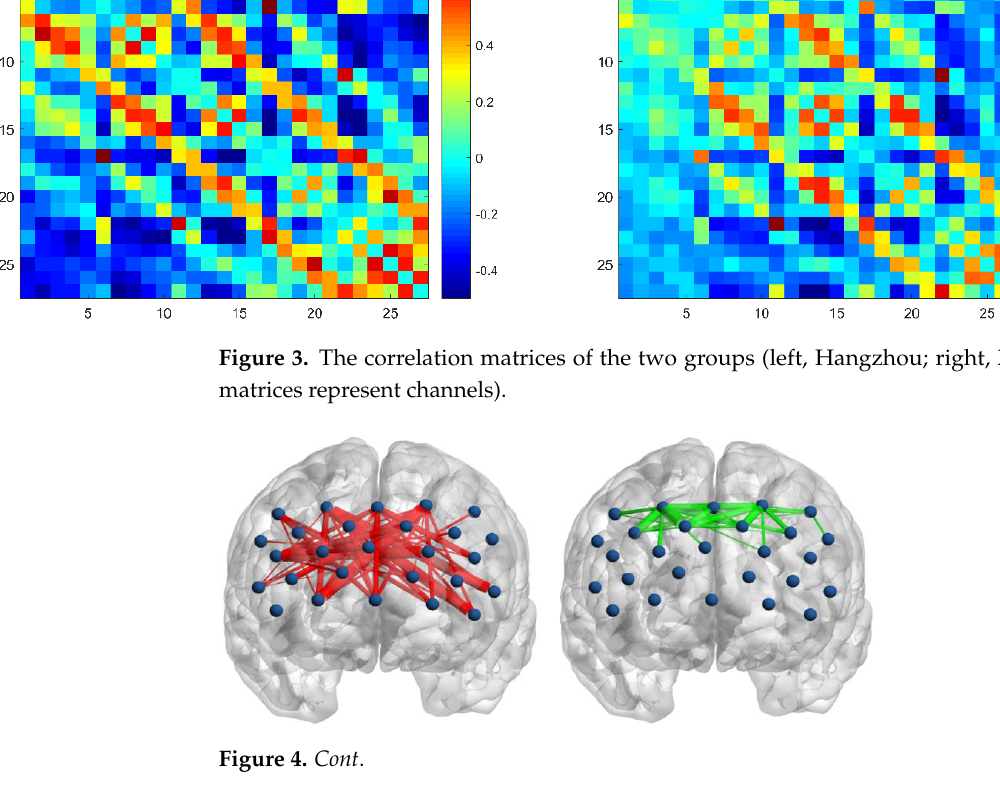
Figure 4. The results of functional connectivity. The red lines denote increased functional connec- tivity in the Xining group compared with the Hangzhou group, while green lines denote decreased functional connectivity. The thickness of the line indicates the strength of the connection. The blue dots denote 27 measurement channels. 3.3. Global Network Properties The results of global network properties showed that, over the sparsity range, σ was greater than 1 ( p < 0.01) in the two groups. Thus, the networks of both groups showed small- world properties. No significant difference was found in the σ between the two groups. For network efficiency, the statistical analyses indicated that the Xining group showed a significant increase ( p < 0.001) in global efficiency and a significant decrease ( p > 0.001) in local efficiency compared with the Hangzhou group. Furthermore, significant decreases were also found in the clustering coefficient ( p < 0.001) and characteristic path length ( p < 0.01) in the Xining group compared with the Hangzhou group (Figure 5).